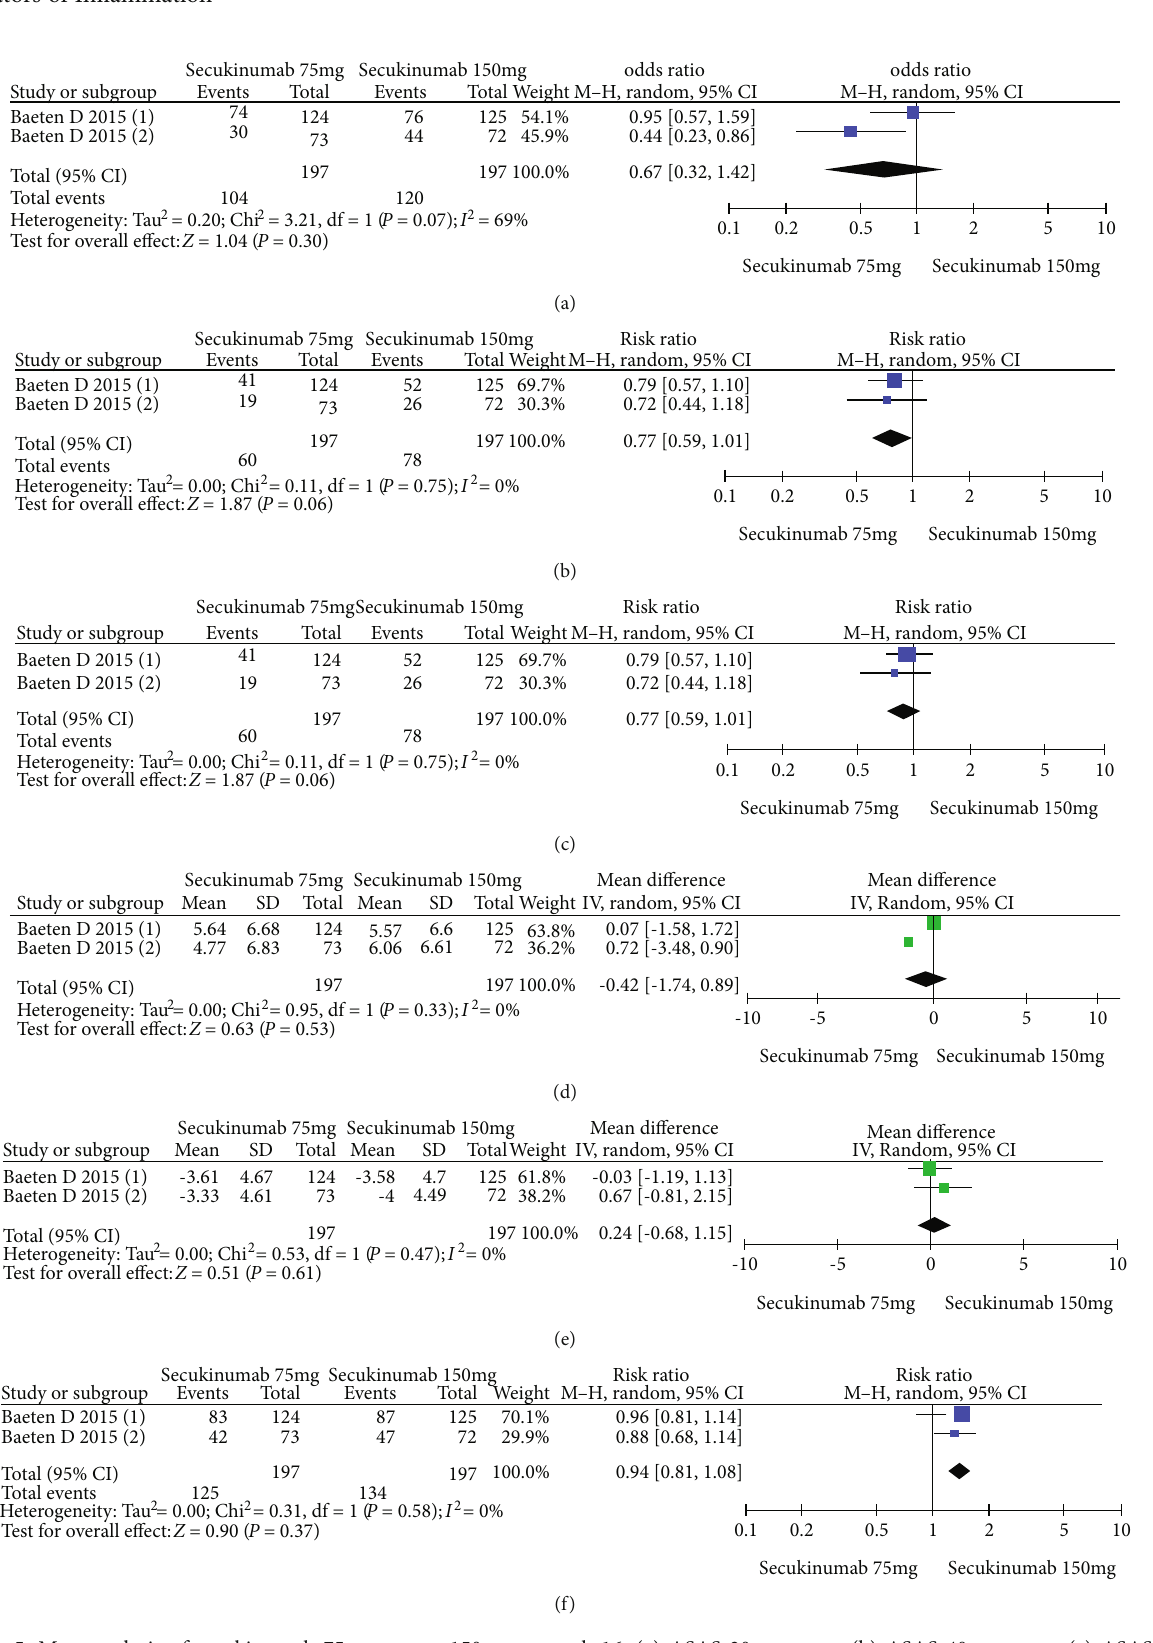
Figure 5: Meta-analysis of secukinumab 75 mg versus 150mg at week 16. (a) ASAS 20 response, (b) ASAS 40 response, (c) ASAS 5/6 response, (d) SF-36 PCS score (change from baseline), (e) ASQoL score (change from baseline), (f) AEs. Baeten 2015 (1): MEASURE 1 study, Baeten 2015 (2): MEASURE 2